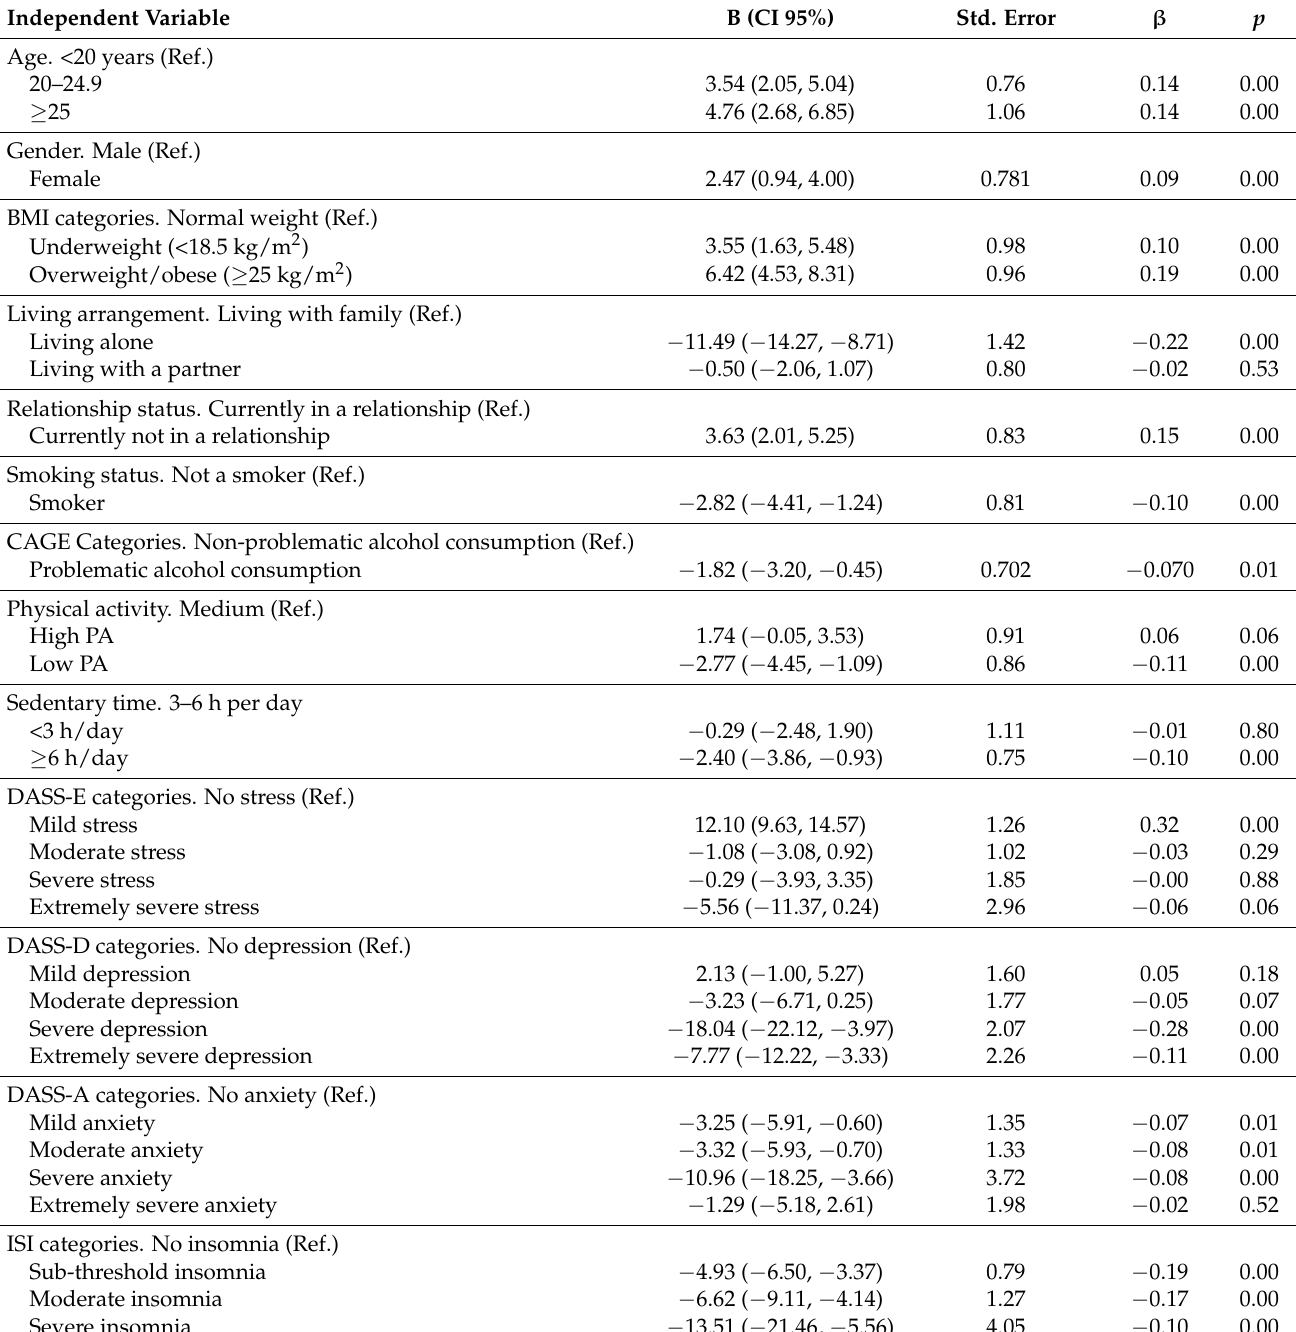
Table 3. Factors related to diet quality. Multiple linear regression model